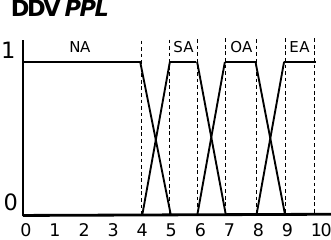
Figure 3. Domain of definition of the variable PPL .